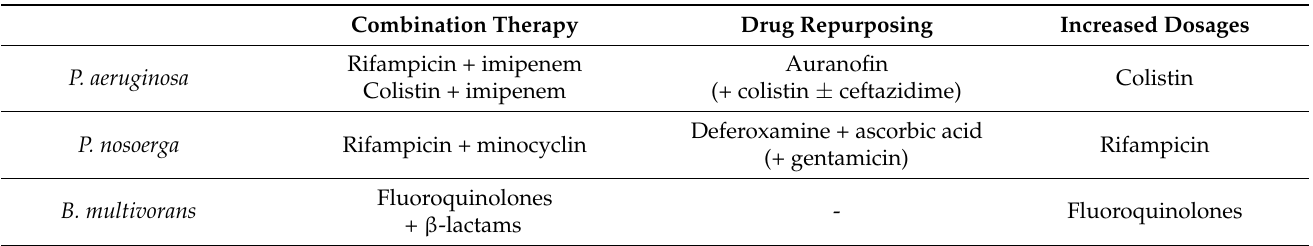
Table 3. Possible alternative solutions for the selected XDR strains with in vitro activity. If the doses of these antibiotics are increased, it is to consider improved efficacy. However, this must be monitored if the dosages would be beyond the recommendations (for renal function, serum concentrations, etc.) and these molecules are not recommended for use as